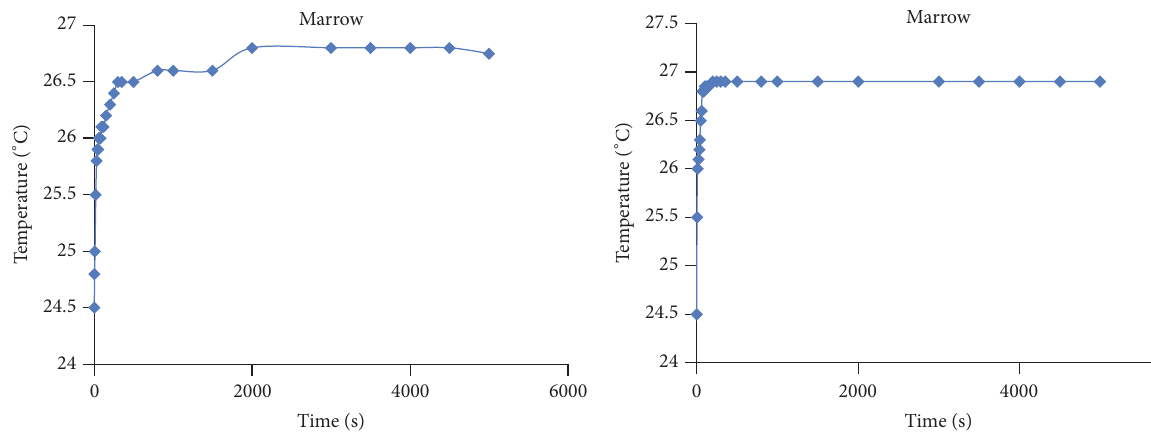
Figure 6: Variation of the water temperature of the calorimeter after the introduction of the hot marrow.